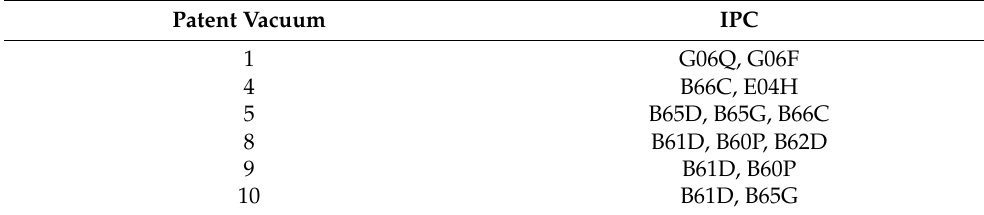
Table 3. Subclass corresponding to the patent vacuum 1 .